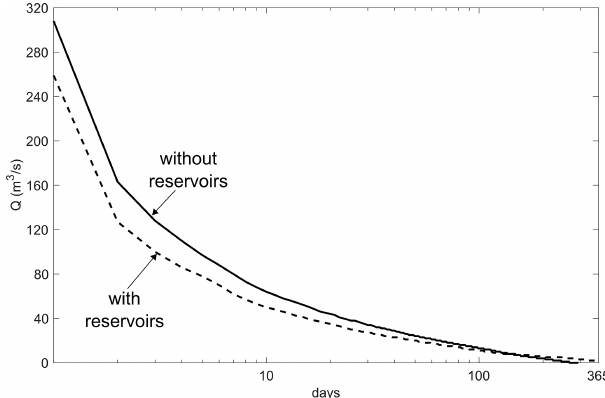
Figure 5. Flow duration curves at the gauging station (see Fig. 1 for location) with and without reservoirs. Log scale for